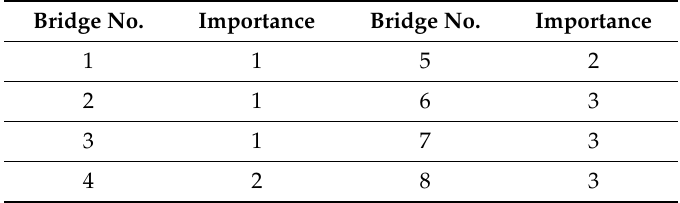
Table 6. Data for bridge